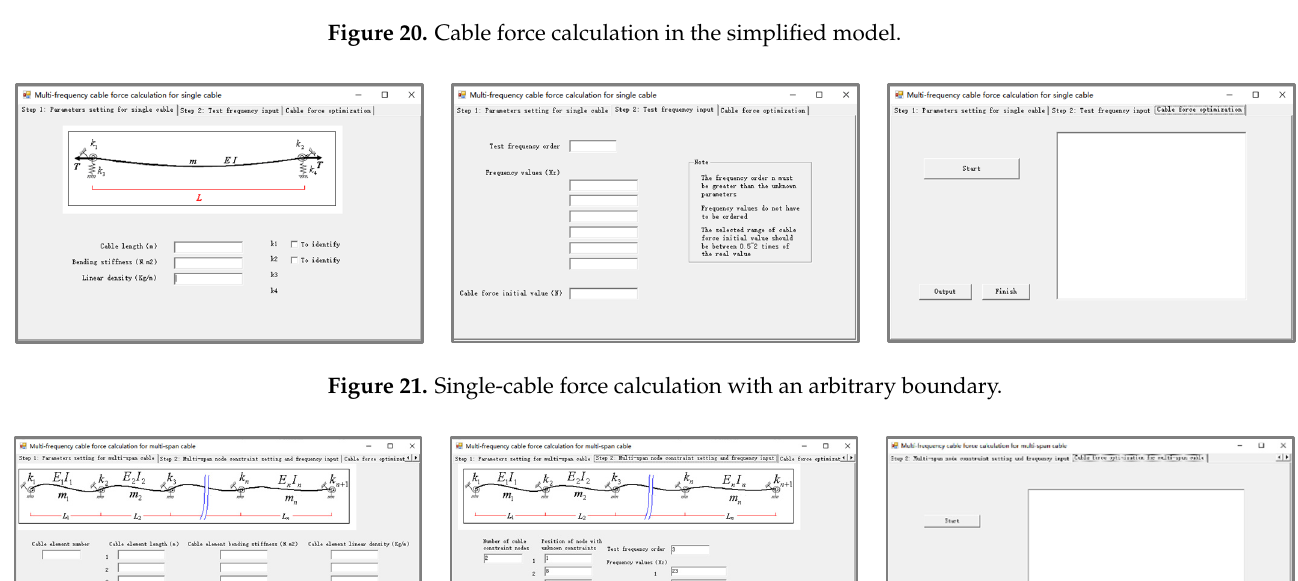
Figure 22. Multi-span cable force calculation.